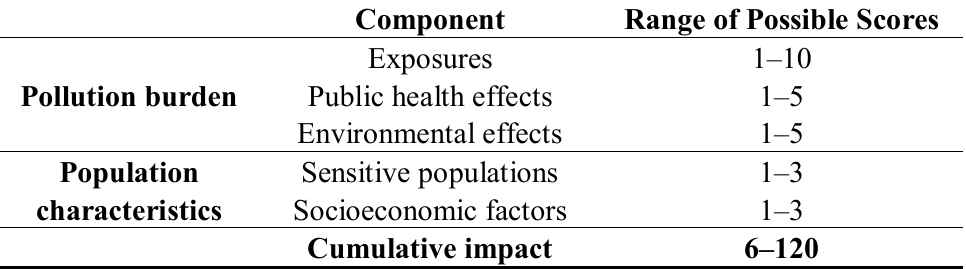
Table 1. Range of scores assigned for each